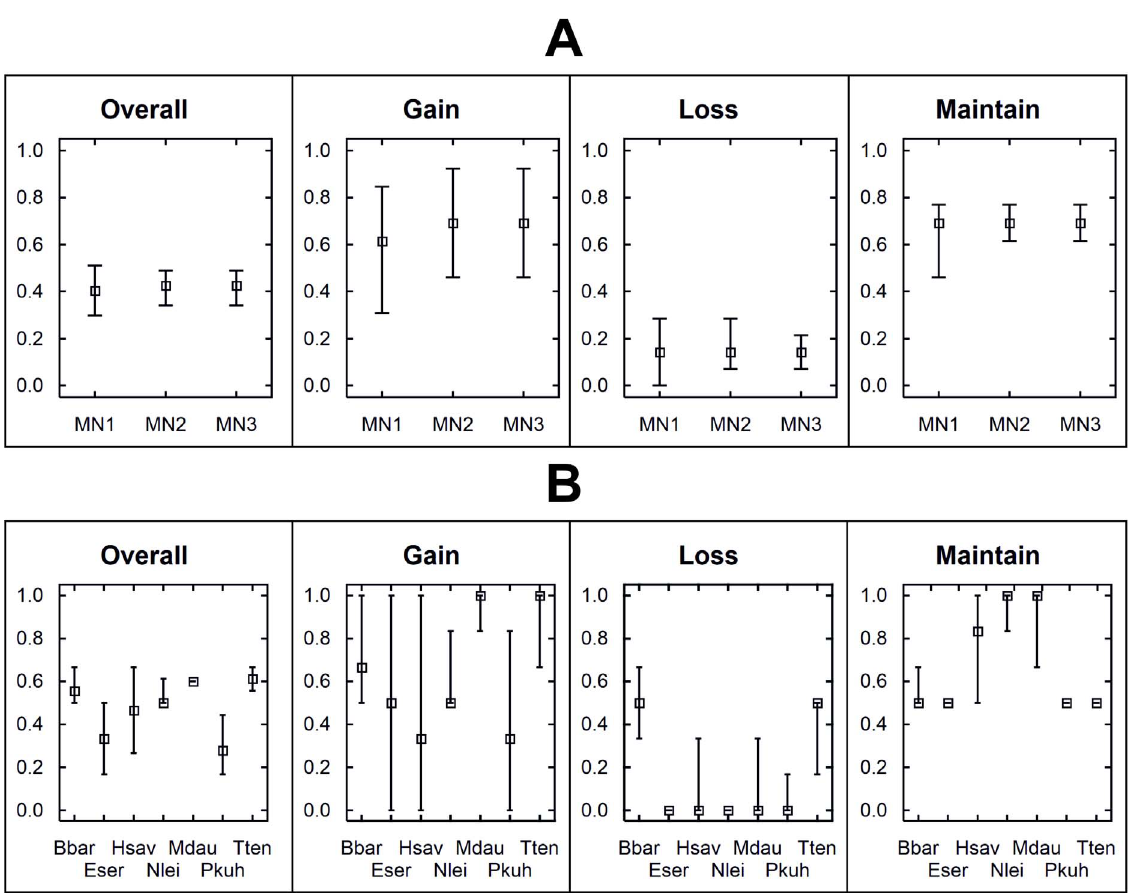
Figure 6. Proportion of targets that were not met in each of the testing networks (A) and by species (B). Proportion of targets that were not met by the 100 runs in each of the testing networks (A) and by species (B) considering overall targets and targets set for each suitability class. Median, maximum and minimum values are presented. Species code as follow: Barbastella barbastellus (Bbar); Eptesicus serotinus/isabellinus (Eser); Hypsugo savii (Hsav); Nyctalus leisleri (Nlei); Myotis daubentonii (Mdau); Pipistrellus kuhlii (Pkuh); and Tadarida teniotis (Tten).